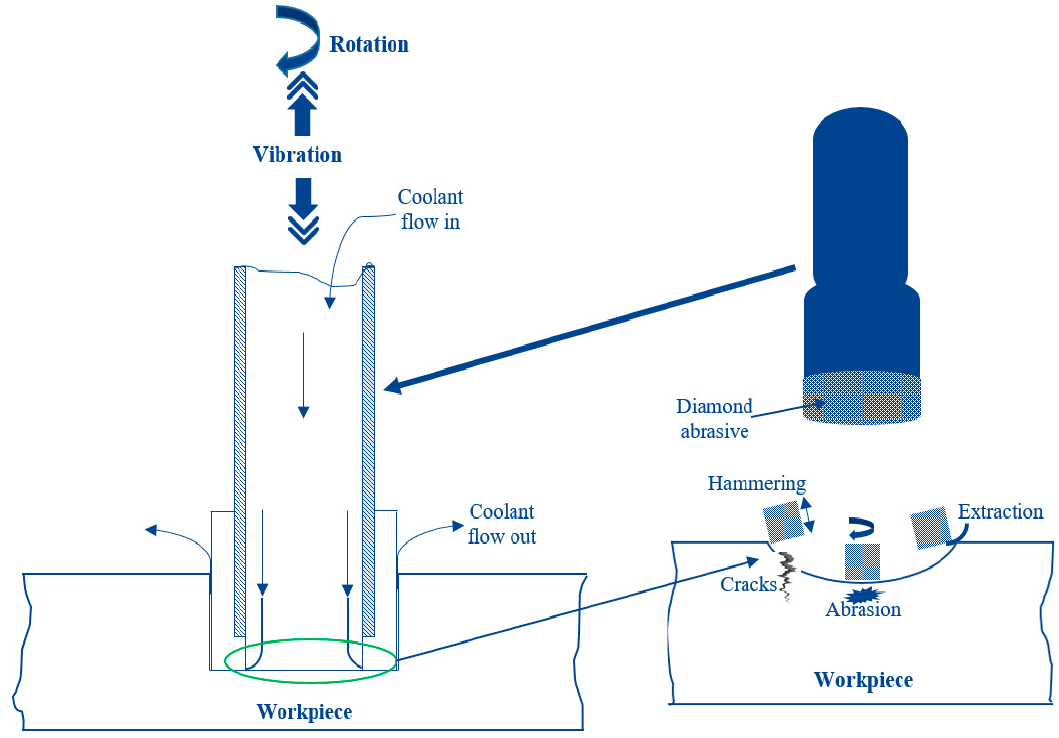
Figure 1. Rotary ultrasonic machining (RUM) working principle for material removal.